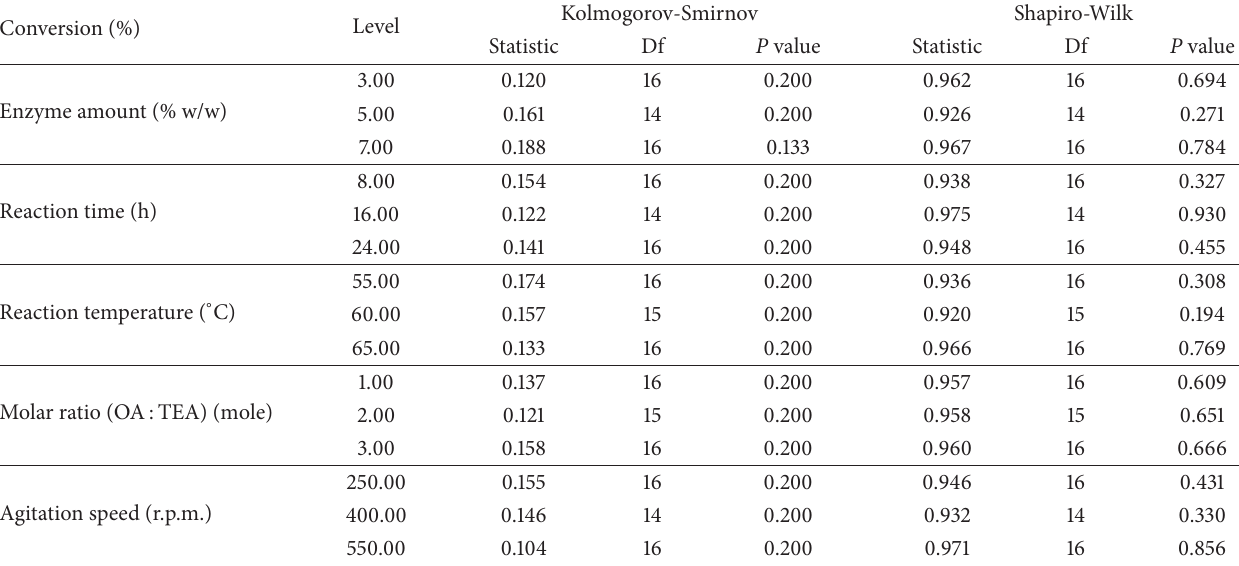
Table 3: The Shapiro-Wilk and Kolmogorov-Smirnov tests for five